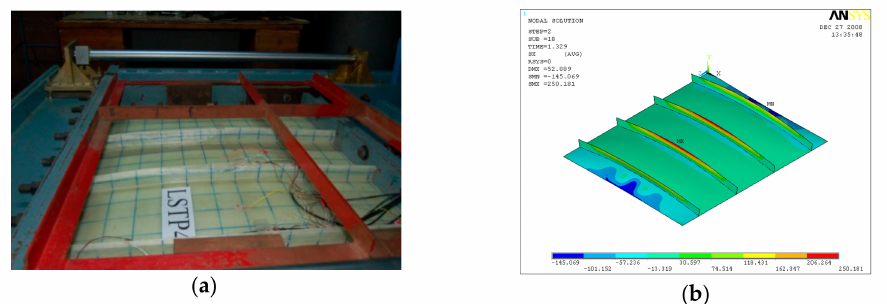
Figure 19. Failure of LSTP3. ( a ) Experiment ( b ) FEA.